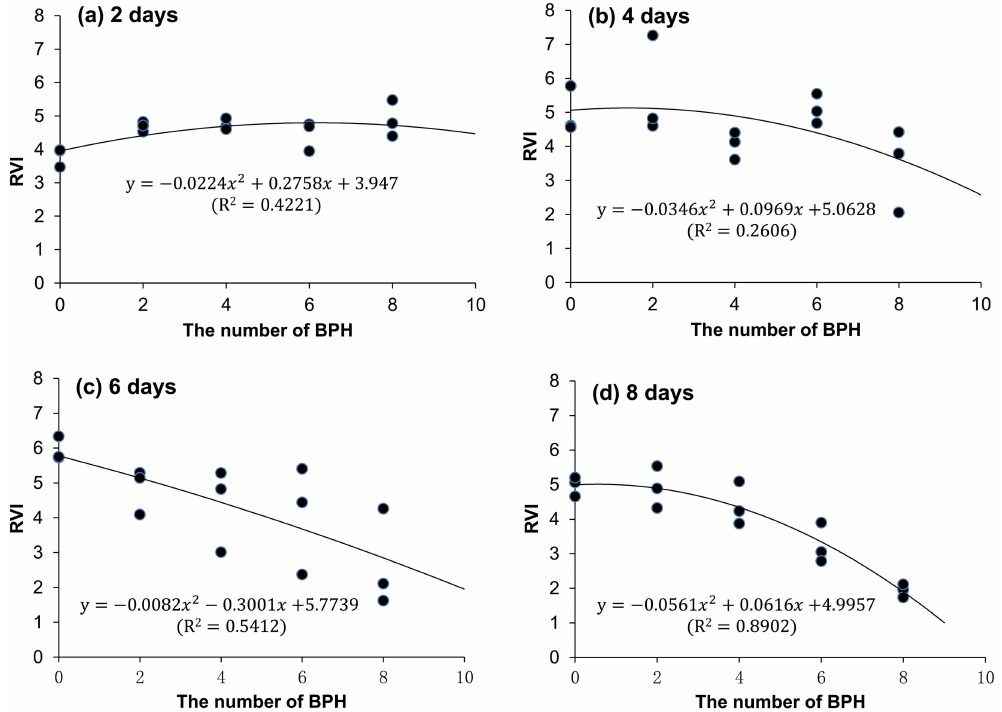
Figure 7. Relationships between RVI 746/670 of a rice plant and the number of BPH nymphs damaged rice for 2 ( a ), 4 ( b ), 6 ( c ), and 8 ( d )